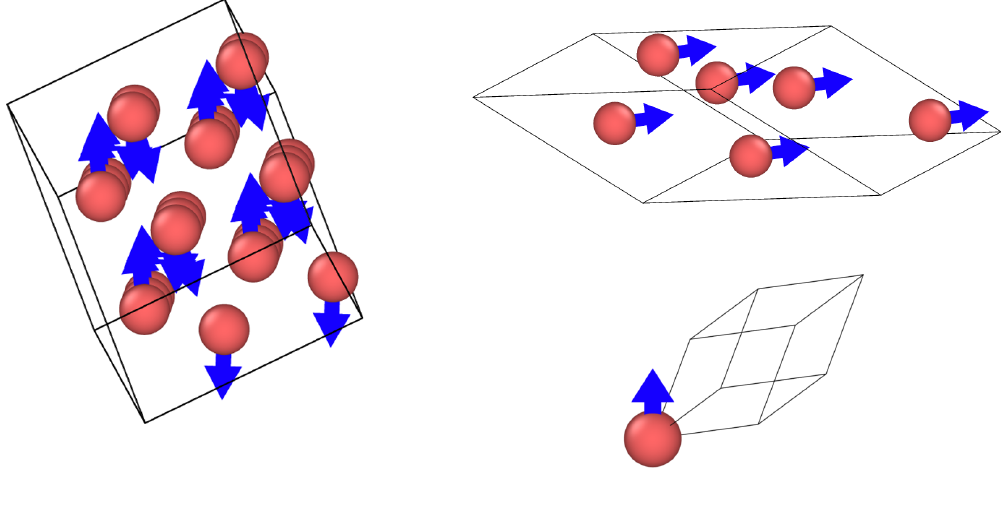
Figure 11. Lowest enthalpy structures for the AFM ( left ) and FM ( top right and bottom right ) parameterisations of the LJ + S model. For the FM parameterisation, both the six-atom unit cell ( top right ) and primitive cell ( bottom right ) are shown. For the AFM parameterisation, a 2 × 2 × 1 supercell is shown to emphasise the BCC